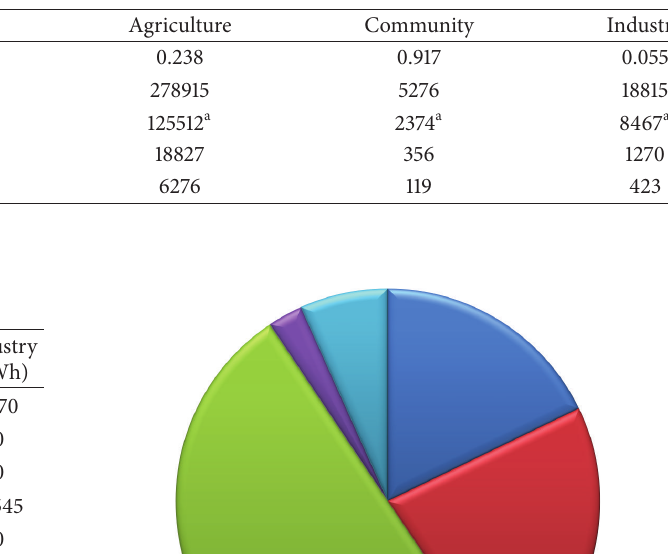
Table 2: Parameter values for different end uses.